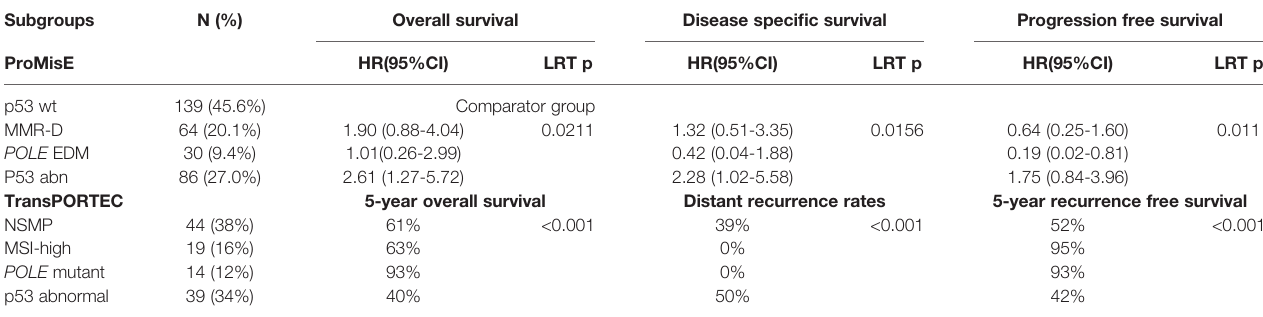
TABLE 4 | Prognostic performance of ProMisE and TransPORTEC classi fi ers, adapted from (49) and (48), respectively.